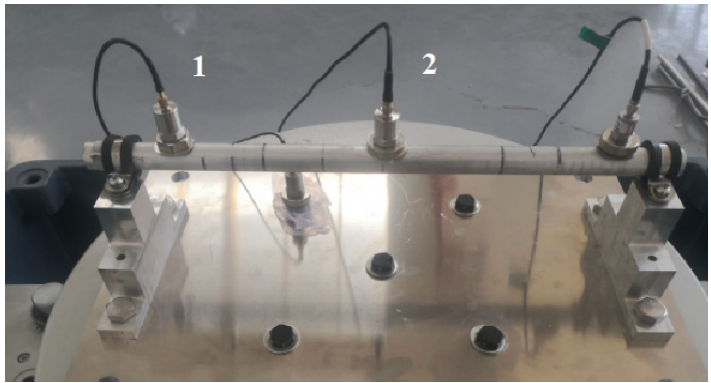
Figure 8. Test layout. Table 9. Hard-coated aviation hydraulic clamp-pipeline vibration response test